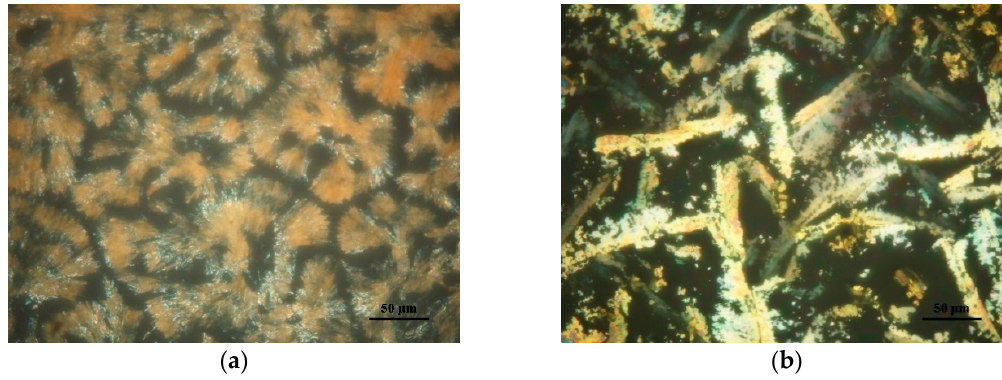
Figure 7. Polarized optical microscopy of ( a ) Azo at 60 °C, ( b ) 75:25 Azo/PEG at 60 °C. The complex compositions are designated in wt %.